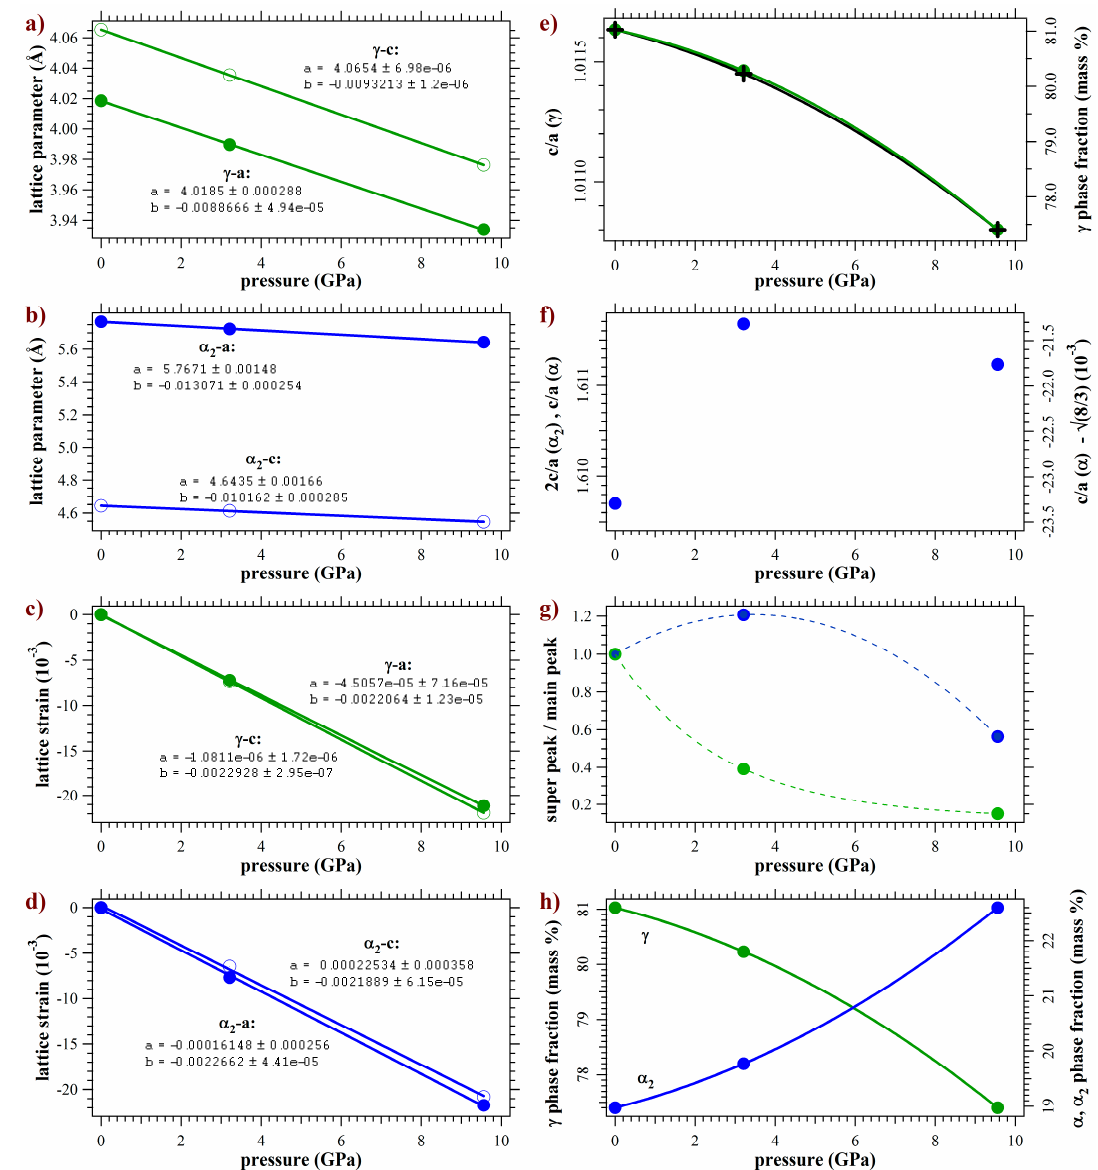
Figure 8. Evolution of structural parameters, phase fraction and diffraction intensity under pressure. Lattice parameters ( a , b ) and lattice strain ( c , d ) with linear fits y = a + bp ; axis ratios ( e , f ); super ‐ structure peak intensities, plotting ratios of super/main peak at pressure, normalized to the super/main peak at ambient pressure ( g ); and phase ‐ fractions ( h , superimposed to e ).